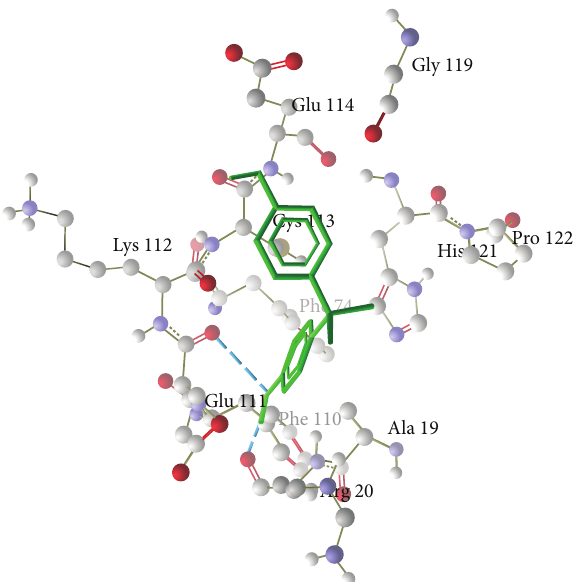
Figure 7: Correlation between bisphenol A and different concen- tration of bisphenol A along with the H 2 O 2 (0.05mM).